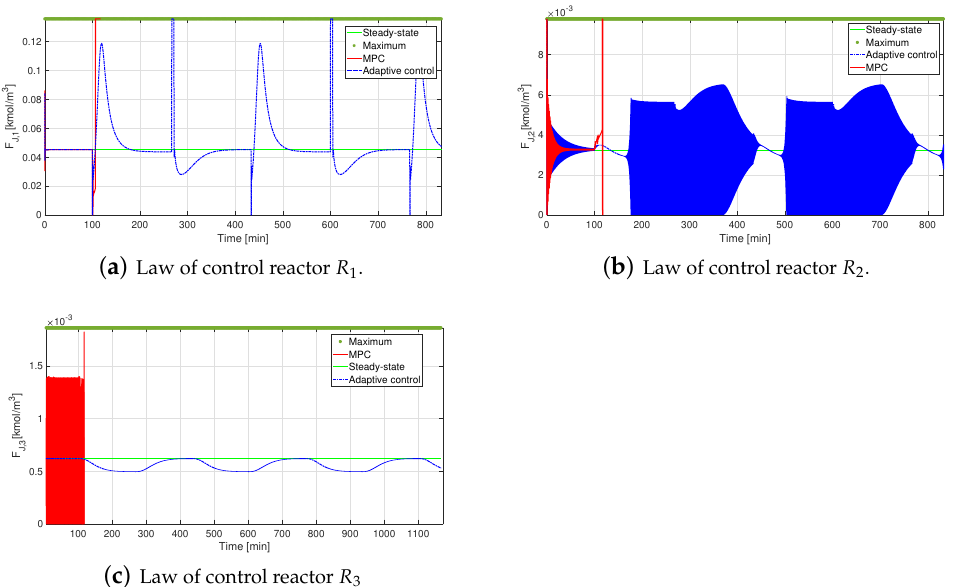
Figure 11. Performance of adaptive controller under an abrupt change in temperature in reactor R 1 in Jacket flows.